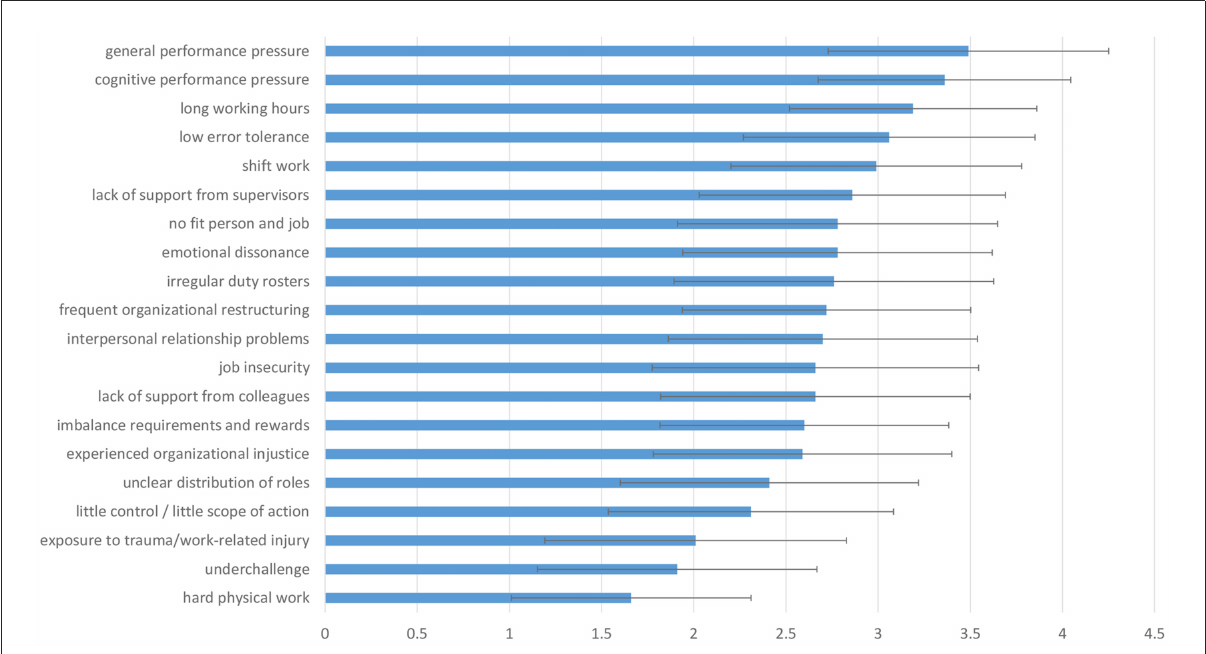
FIGURE2 Suspected reasons for PNE PD use among employees. It shows the mean and standard deviation of a four-point Likert scale (1, “completely unimportant” to 4, “very important”).